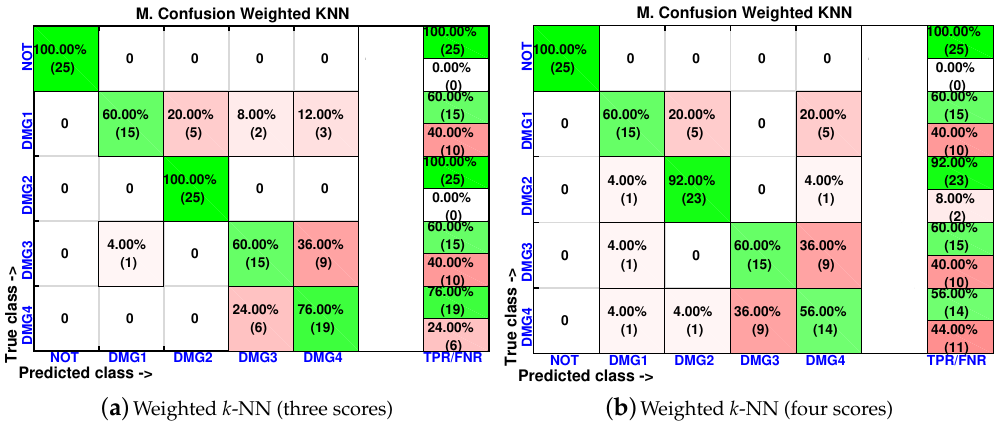
Figure 19. Confusion matrix using weighted k -NN when the feature vector is formed by the first three principal component ( a ) or by the first four principal components ( b ).